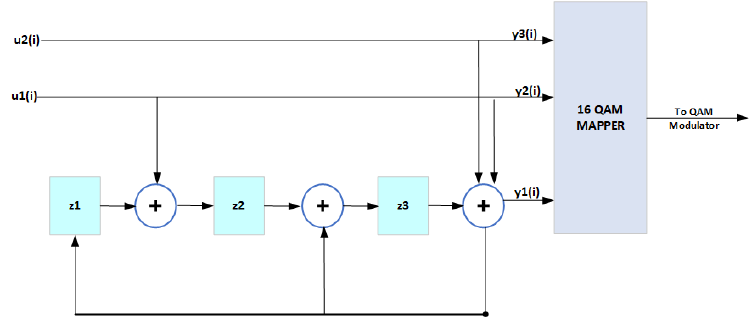
Figure 5. TCM Encoder with QAM